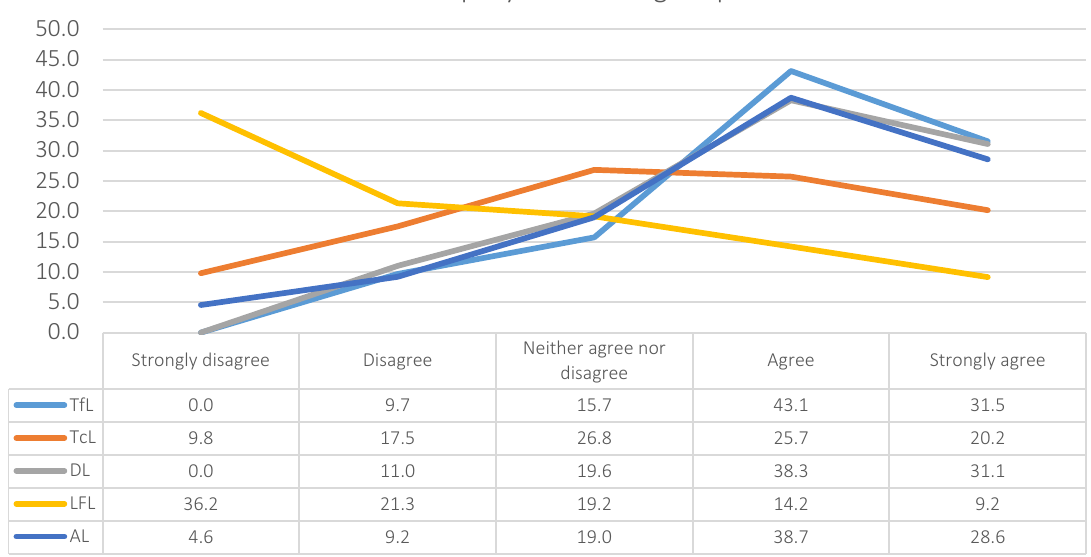
Figure 4. Leadership styles for banks with foreign